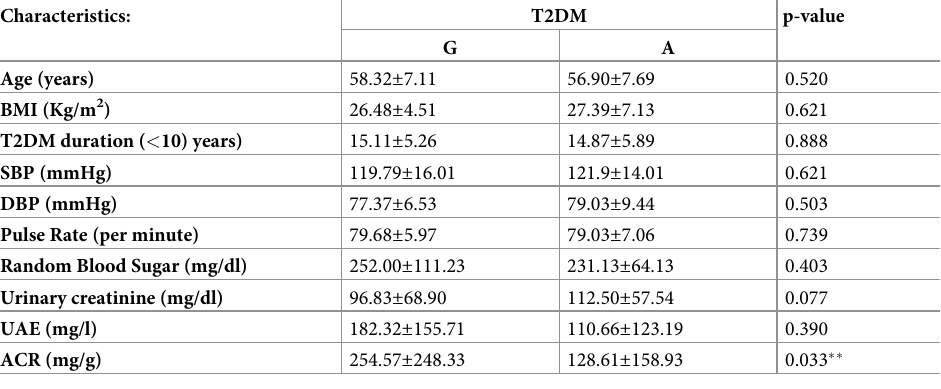
Analysis by independent sample t-test. � significant at the level of 0.05 and �� highly significant at the level of